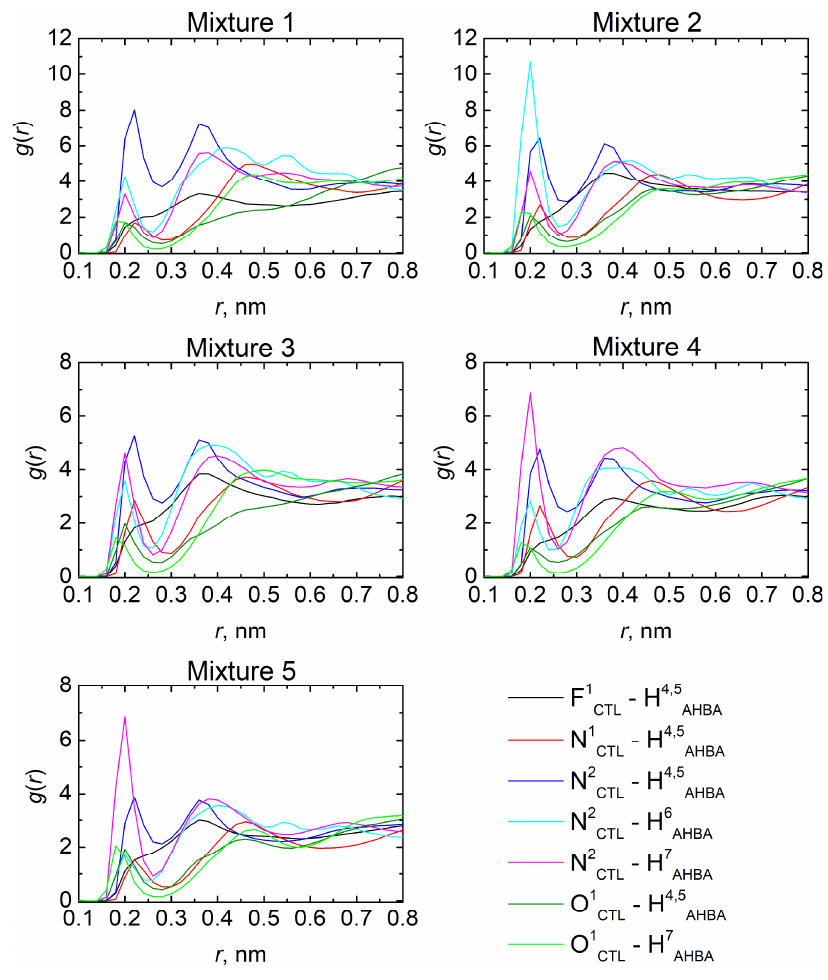
Figure 2. Radial distribution functions, g(r), between specific sites of CTL and AHBA molecules in the studied pre ‐ polymerization mixtures from the results of molecular dynamics simulations.